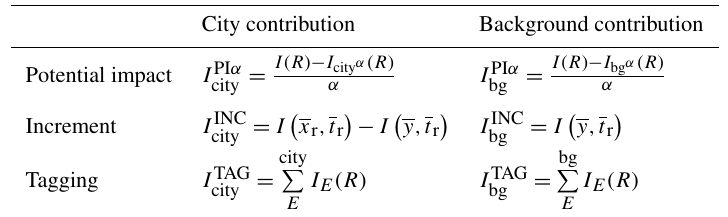
Table 1. Formulation of the three main methods to estimate the contribution, potential impact, and increment of a city. The letters, I , S , and R refer to the indicator, source, and receptor, respectively. The indicator superscript refers to the SA method (PI for potential impacts, INC for increments, and TAG for tagging), while its subscript indicates the source (city or background (bg)); α represents the percentage reduction factor applied for the source emissions in the potential impacts method. See text for additional